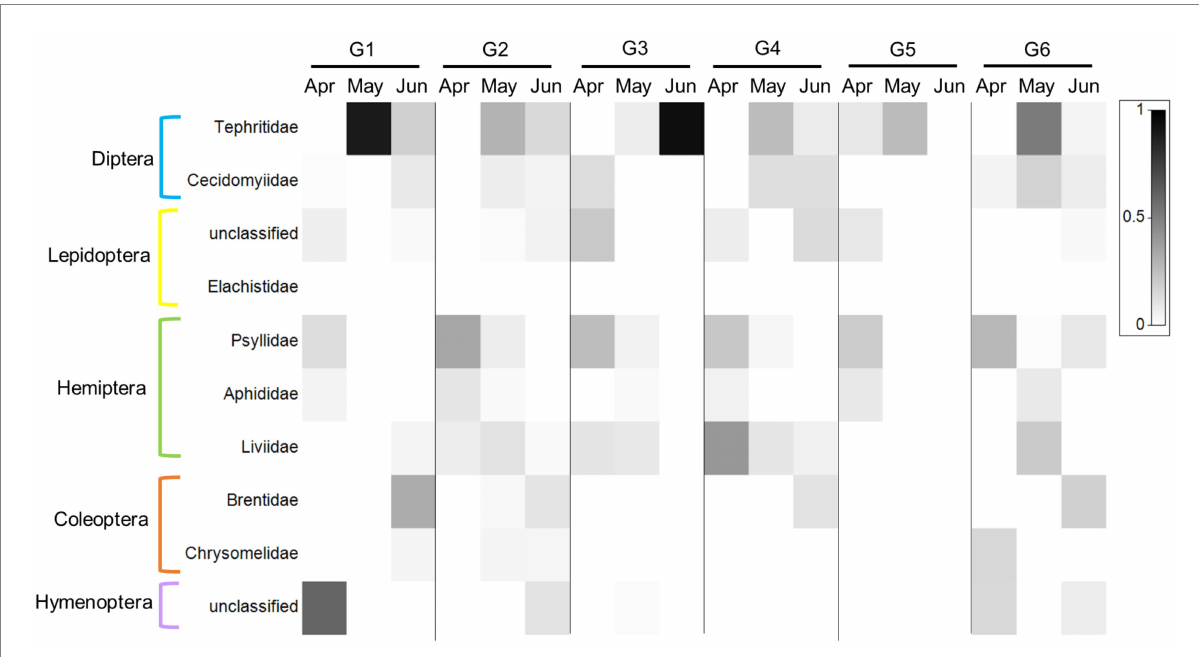
FIGURE 5 Heat map presentation of the most abundant plant-dwelling arthropod families ingested by the six-goat group (G1–G6) across three consecutive sampling months (columns). The 10 most abundant families based on RRA across all samples are presented in this plot. The six goats are marked by G1–G6. The grey scale intensity represents the mean relative abundance of each family (white squares indicate an absence of reads). The plot was prepared using Primer v7 software